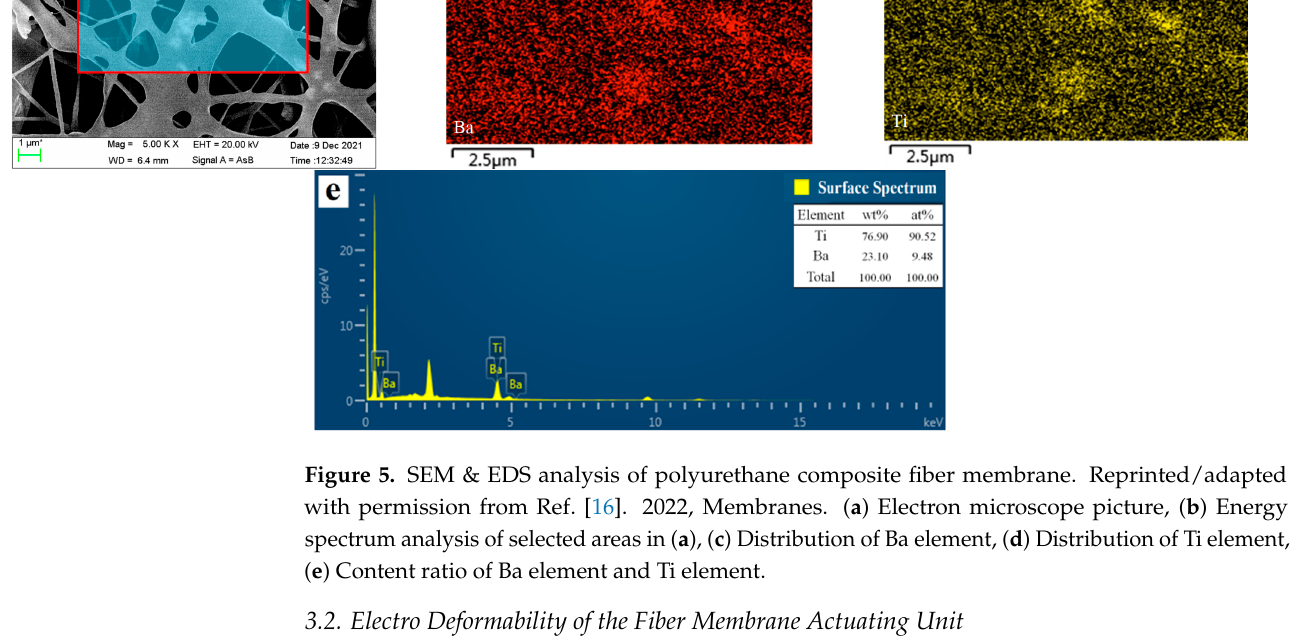
Figure 4. Schematic diagram of electrostrain experimental platform. (1) High-speed camera, (2) Fixed frame, (3) Copper foil, (4) Flexible electrode, (5) Polyurethane composite fiber membrane.